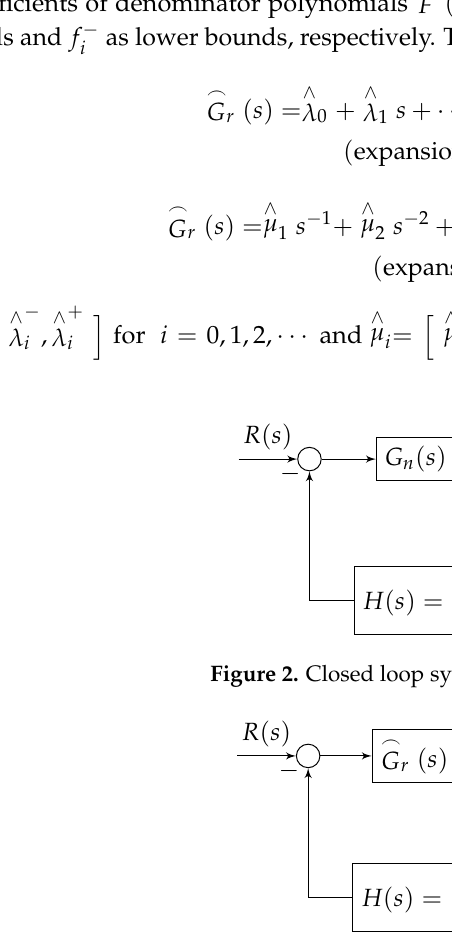
Figure 3: Closed-loop system of reduced-order continuous interval plant (ROCIP).